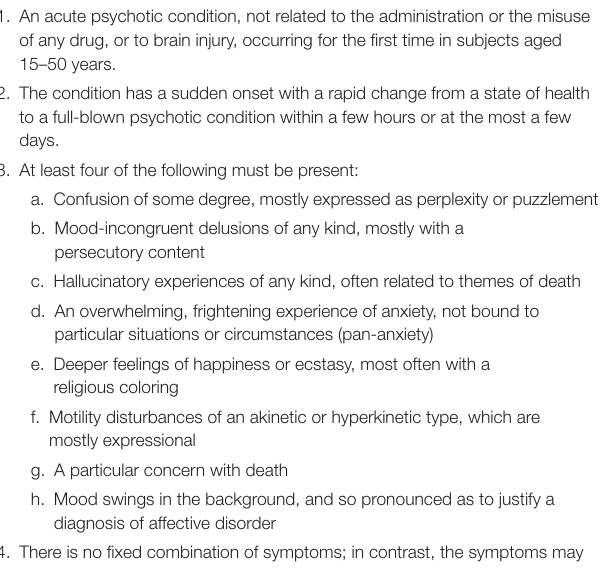
TABLE 1 | Diagnostic criteria for cycloid psychosis according to Perris and Brockington (15).